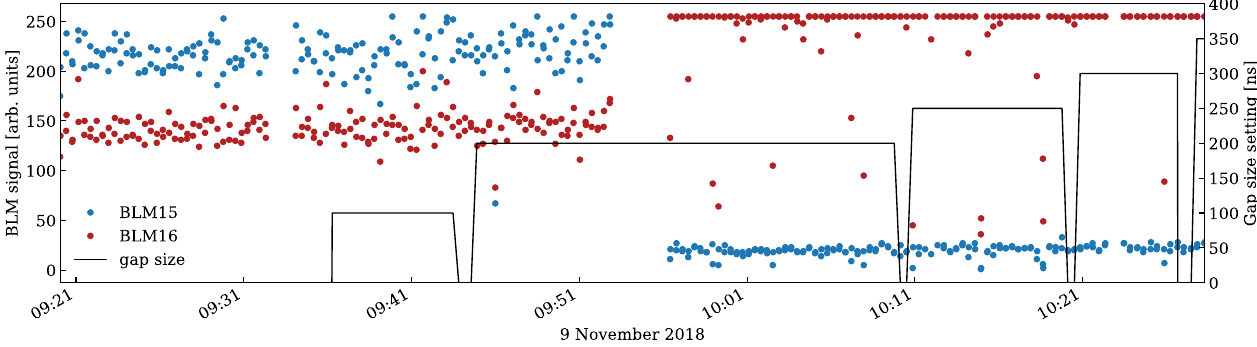
FIG. 12. Evolution of beam losses at PS extraction, measured by means of beam loss monitors installed in SS15 and 16, together with the programmed width of the gap generated in the longitudinal beam distribution by the barrier bucket during the experimental tests. The sudden drop of the BLM15 signal and simultaneous saturation of the BLM16 signal correspond to the copper blade set to parking